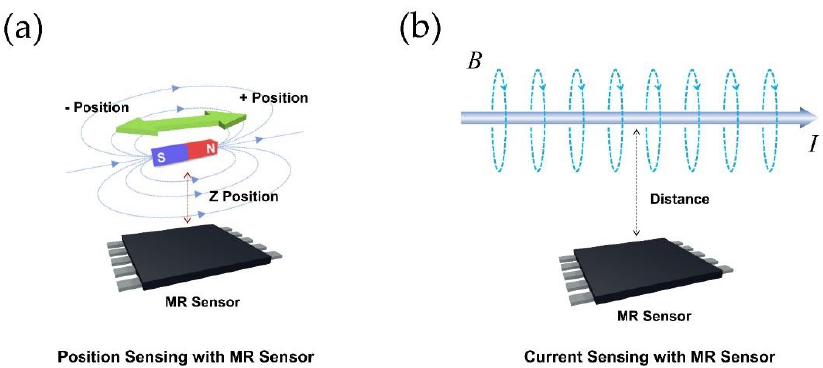
Figure 11. Schematic diagram of ( a ) position sensing and ( b ) current sensing with MR